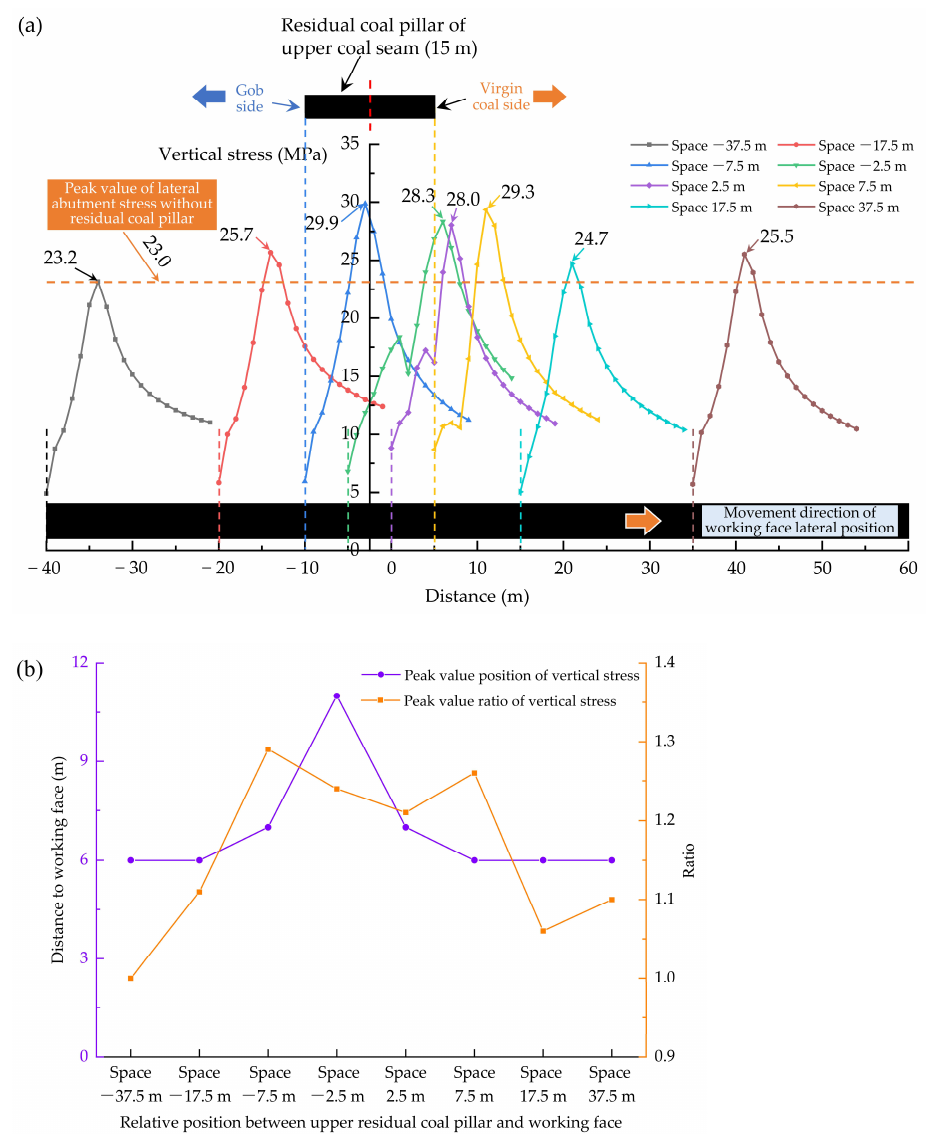
Figure 3. The evolution laws of the lateral abutment stress in lower working face at different relative distances to the RCP. ( a ) Overview under different distances. ( b ) Peak stress ratio and distribution of peak locations. (Note: the gob side and virgin coal side in the figure were both relative to the lower working face).